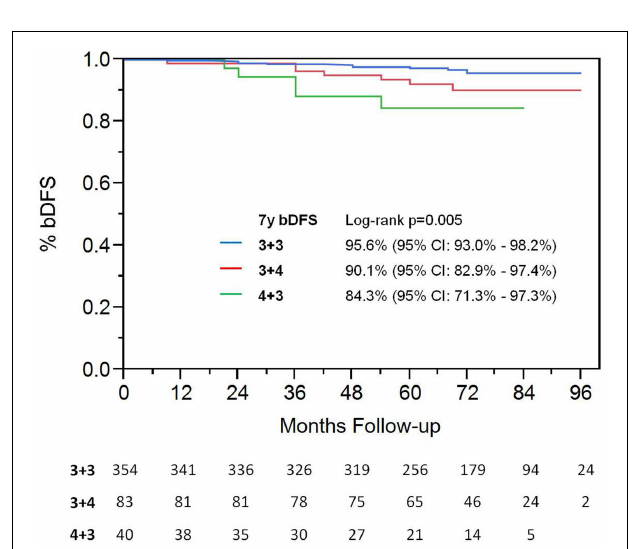
FIGURE 5 | Biochemical disease-free survival stratified by Gleason score .